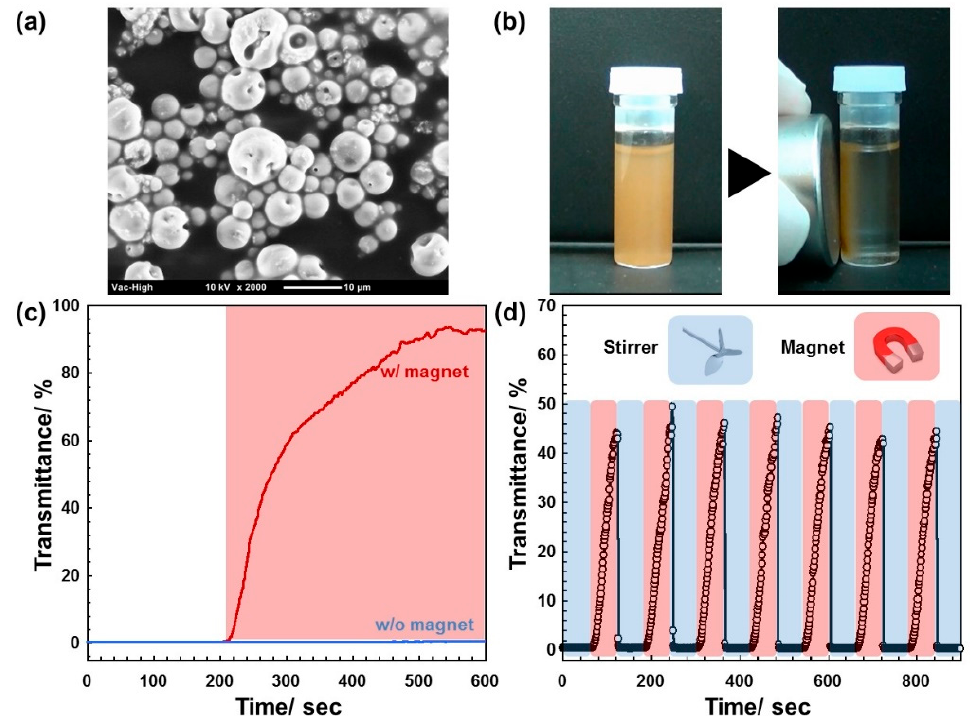
Figure 4. ( a ) Top view SEM image of shape-memory PCL microparticles containing MNPs after size separation by sedimentation technique; ( b ) Photographs of dispersion of purified shape-memory PCL microparticles containing MNPs before and after applying an external magnetic field; ( c ) Time course of magnetophoretic mobility for purified shape-memory PCL microparticles containing MNPs with or without external magnetic field. The measurement was conducted in distilled water; ( d ) Repeatability of magnetophoretic mobility and dispersion of shape-memory PCL microparticles containing MNPs. Stirring (blue) and applying with externa magnetic field (red) were repeated alternately every 60 s for 15 min. ( c , d ) Magnetophoretic mobility was estimated by measuring the optical transmittance at 500 nm.